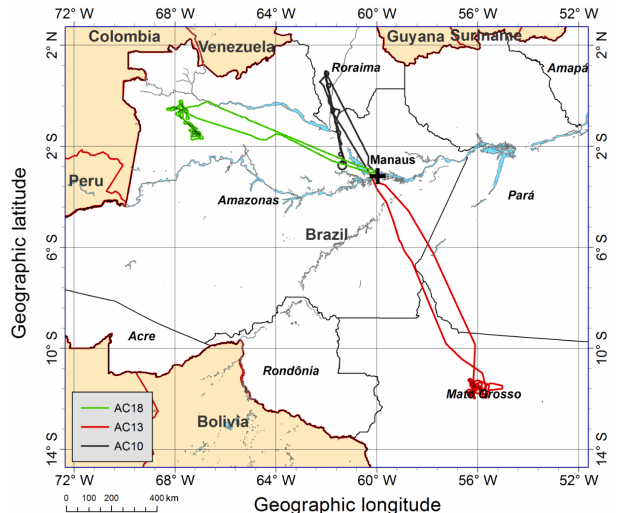
Figure 1. Flight tracks of AC10 (black), AC13 (red), and AC18 (green). The city of Manaus is indicated by the black cross.